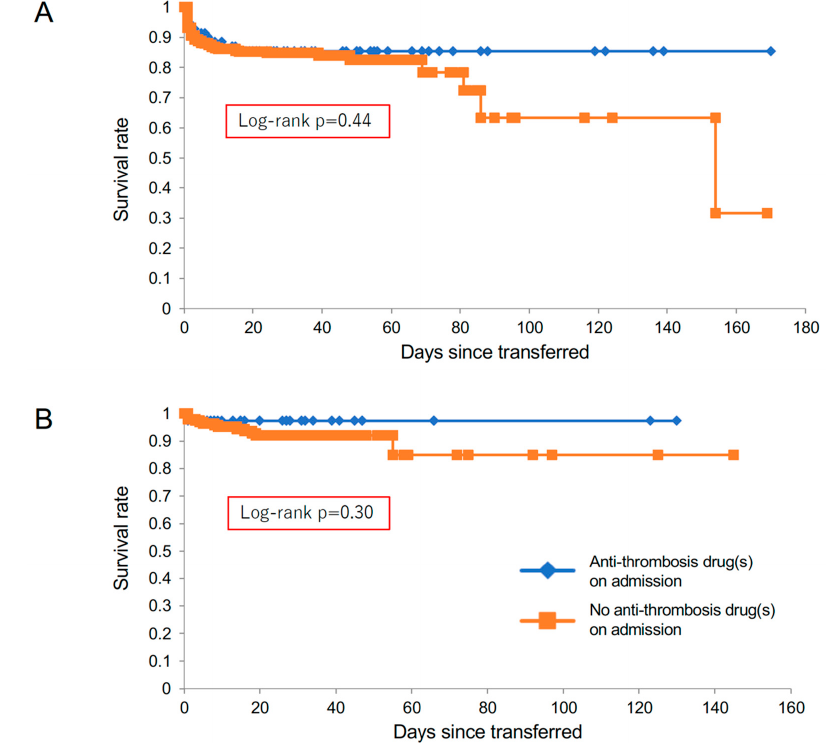
Figure 1. Enrollment of transferred patients with acute aortic dissection. Among 685 transferred patients, 15% of 454 type-A and 16% of 231 type-B patients